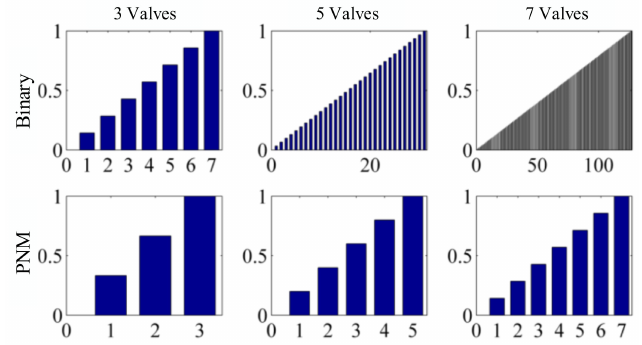
Figure 18. The output of the system with di ff erent encoding